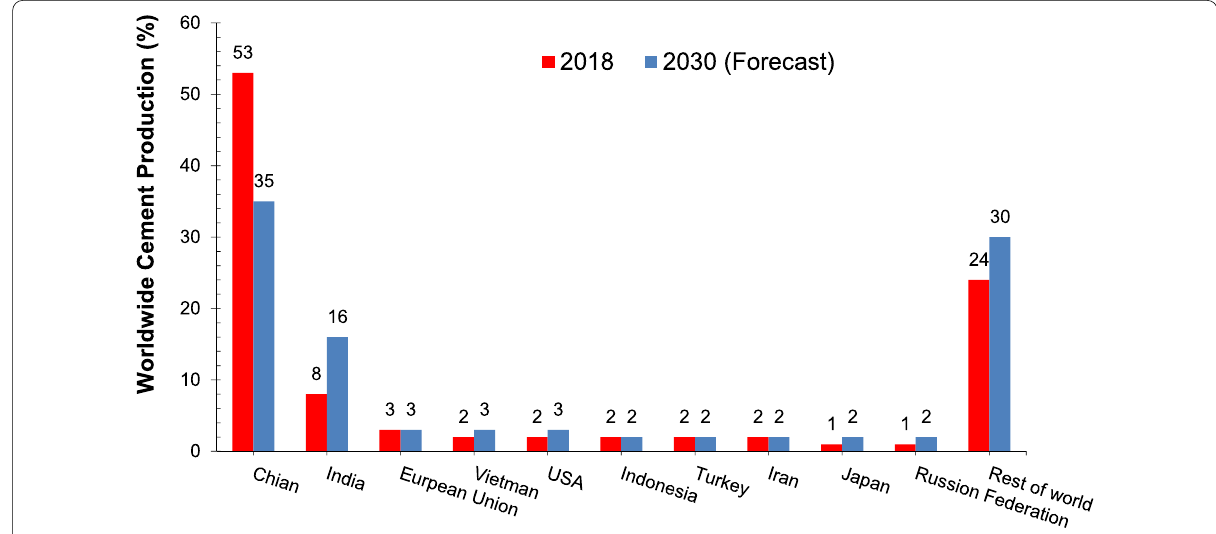
Fig. 1 World cement association (Association WC Oyak